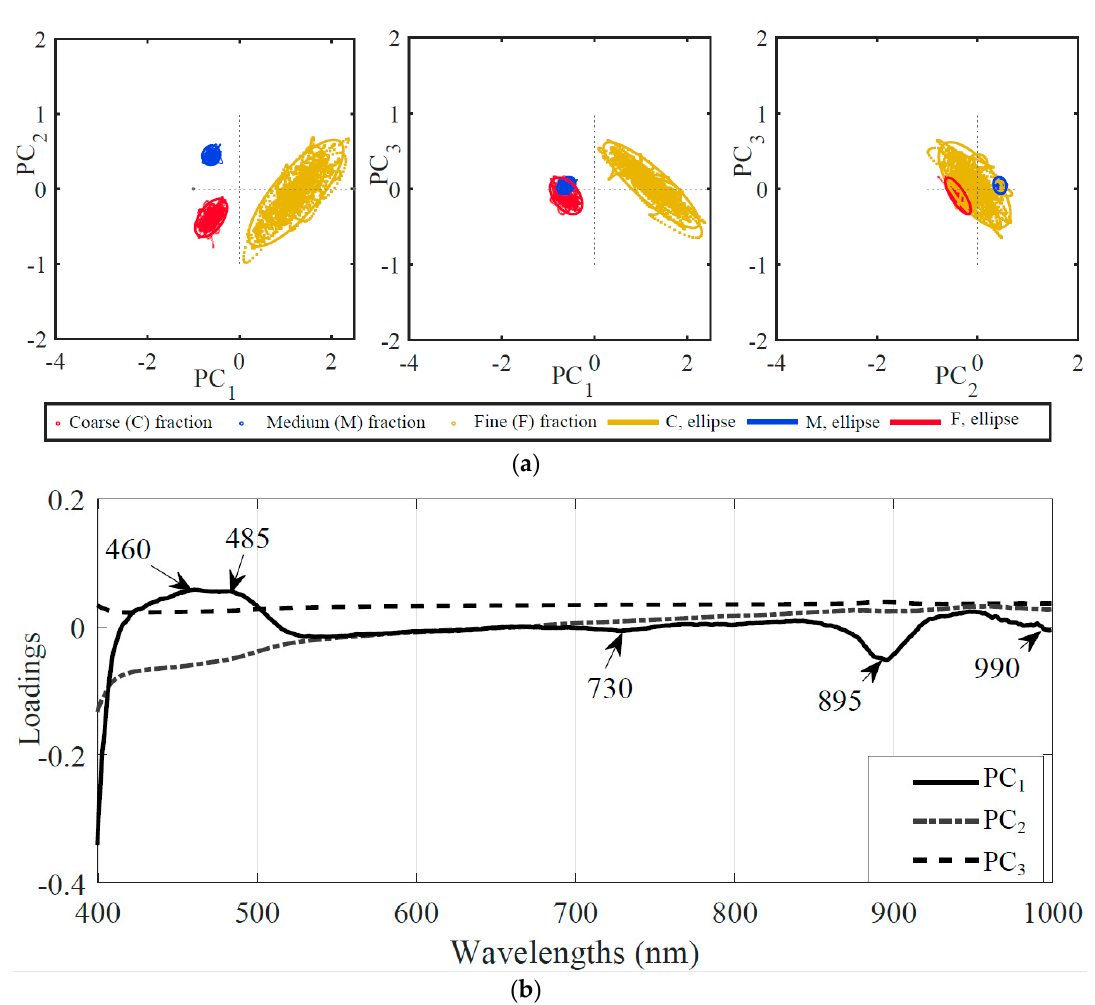
Figure 5. Principal component analysis of coarse, medium, and fine fraction of milk powder samples. ( a ). score plots; ( b ). loading plots.